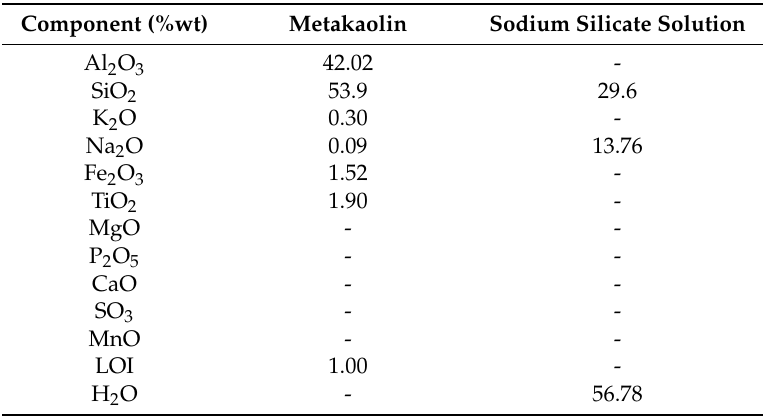
Table 1. Chemical composition of raw